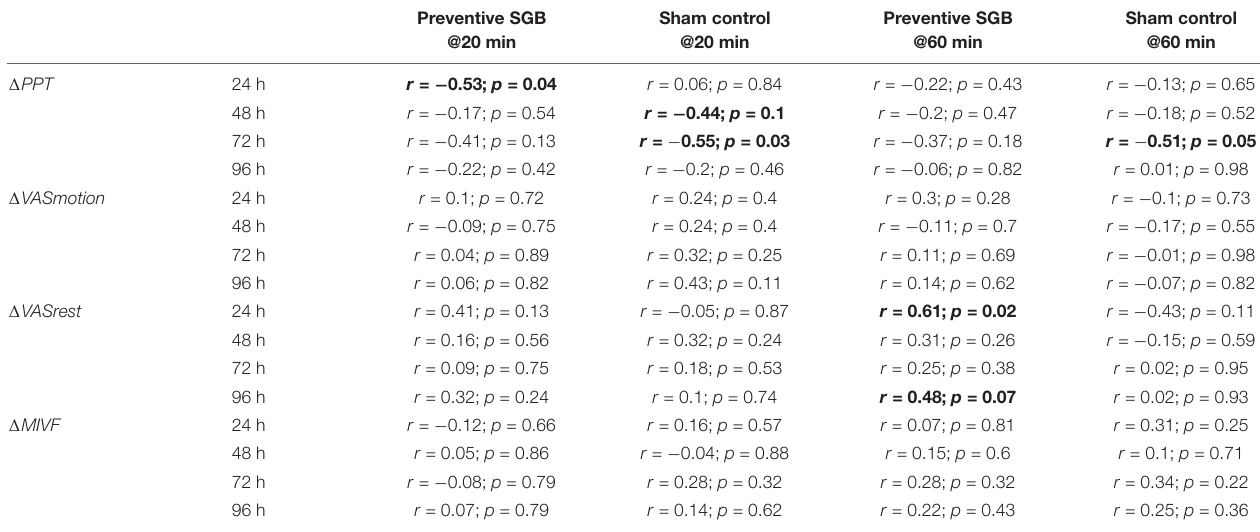
TABLE 4 | Correlations between cfDNA levels and pain